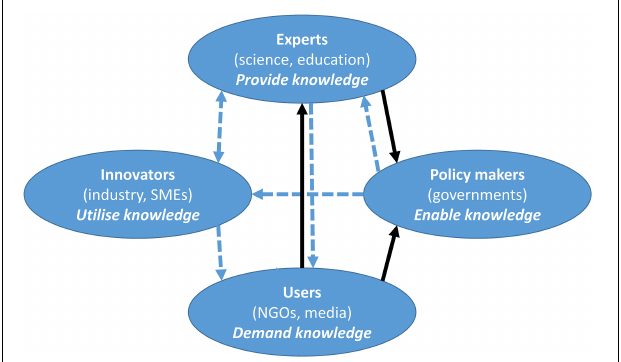
FIGURE 4 | The quadruple helix approach for using non-indigenous species as a source is a two-step process. The first step: black arrows; second step: blue arrows. Communication flow (from-to) is represented by the direction of the arrows. SMEs, small and medium-sized enterprises; NGOs, non-governmental